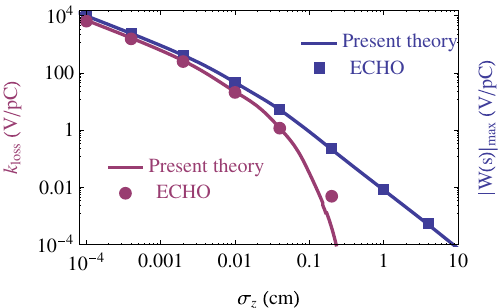
FIG. 4. Loss factor and maximum of the wake